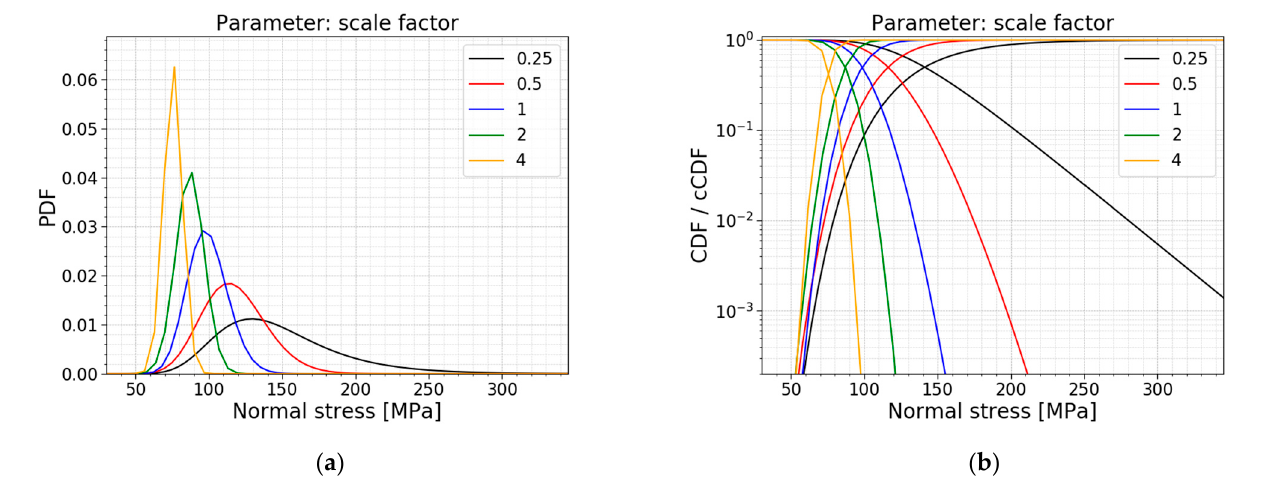
Figure 15. ( a ) PDF and ( b ) CDF for a varying scale factor.